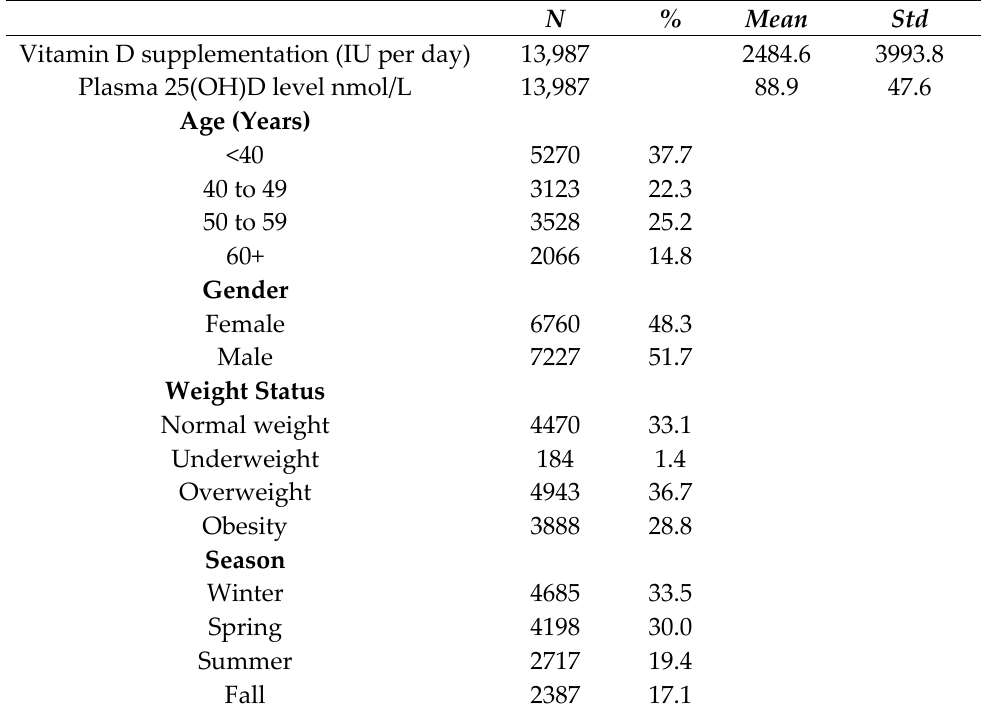
Table 1. Summary of 13,987 simultaneous assessments of reported vitamin D supplementation and serum 25(OH)D level from 11,693